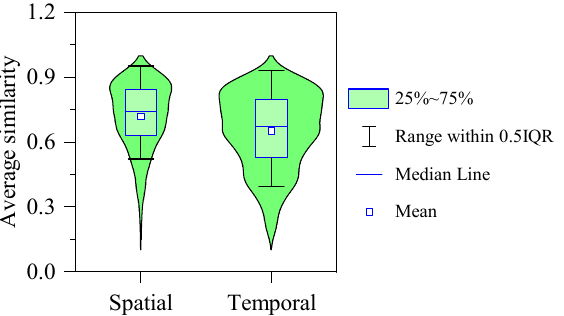
Figure 8. Violin plots showing the average similarity of community structure between sites of spatial and temporal variations.